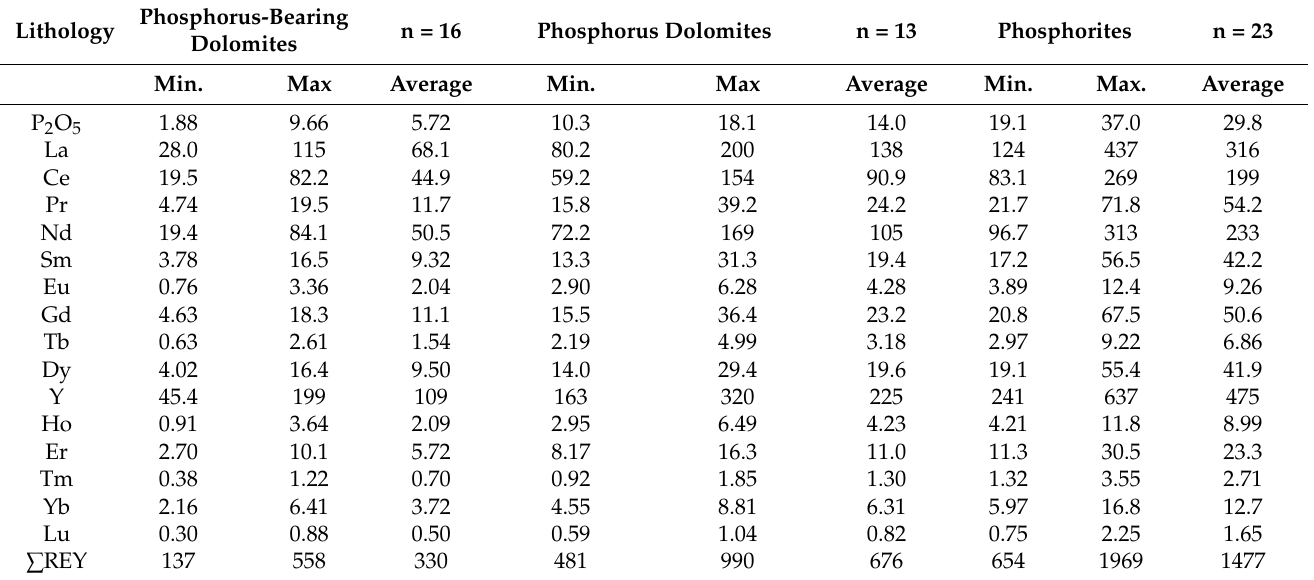
Table 2. The concentrations of major elements (%) and rare earth elements and yttrium (REY) (ppm) of phosphorus rock series from the Zhijin